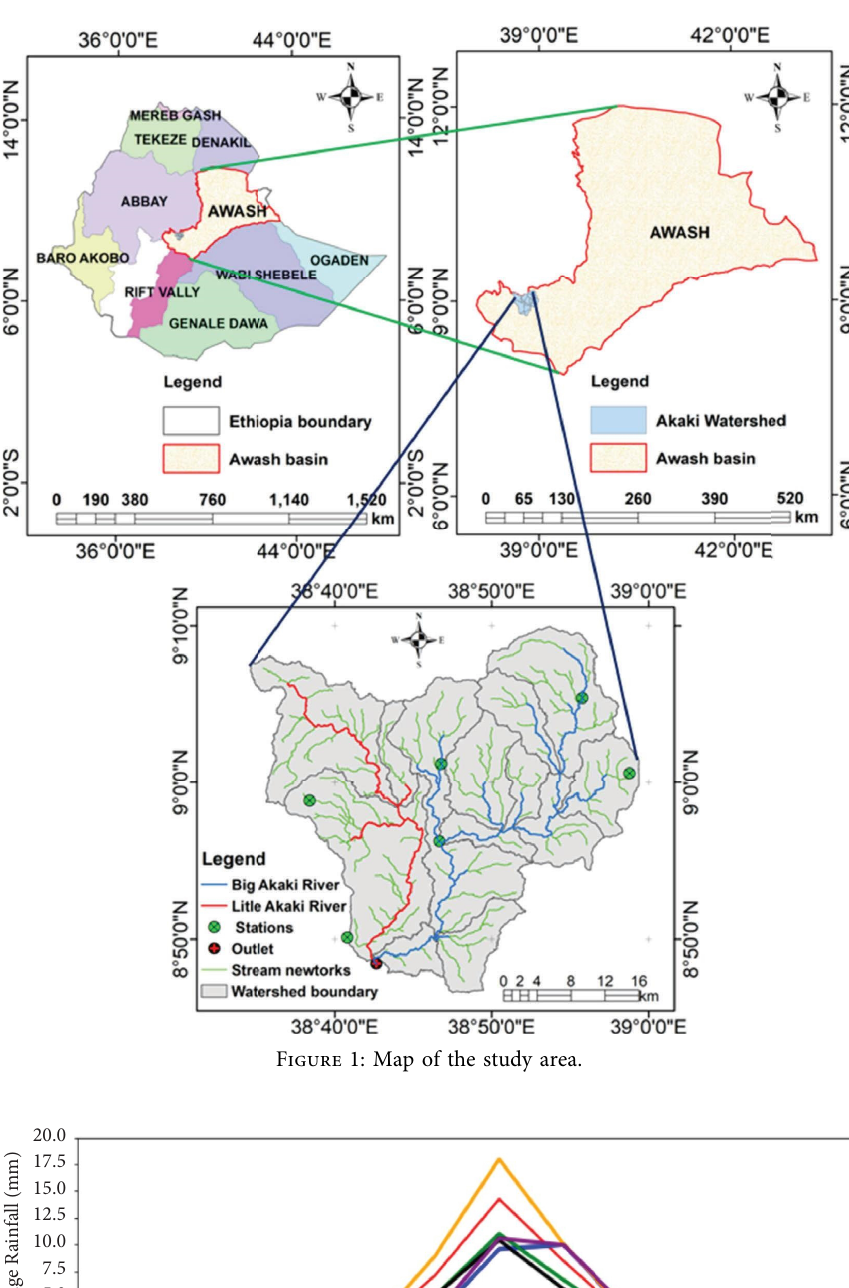
Figure 1: Map of the study area.